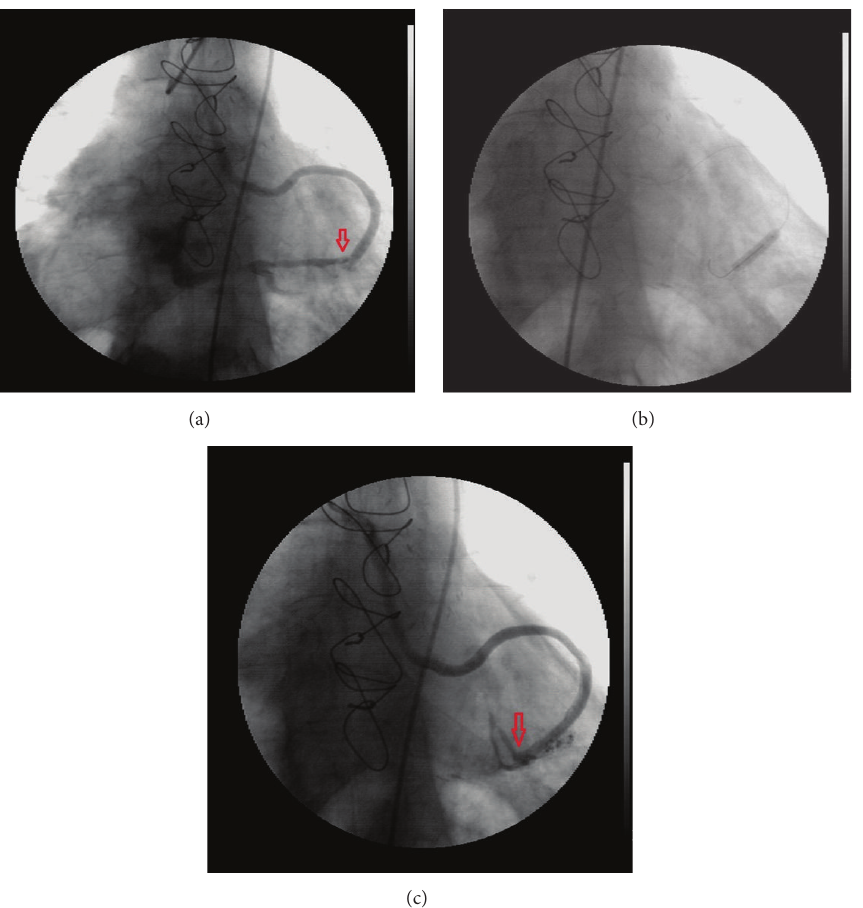
Figure 1: (a) As shown in the figure, the first sequential side to side ligation was inadvertently anastomosed to the left posterolateral coronary vein. (b) The covered stent was implanted at the fistula side. (c) The fistula was totally occluded and a TIMI 3 flow from saphenous vein graft to obtuse marginal artery was